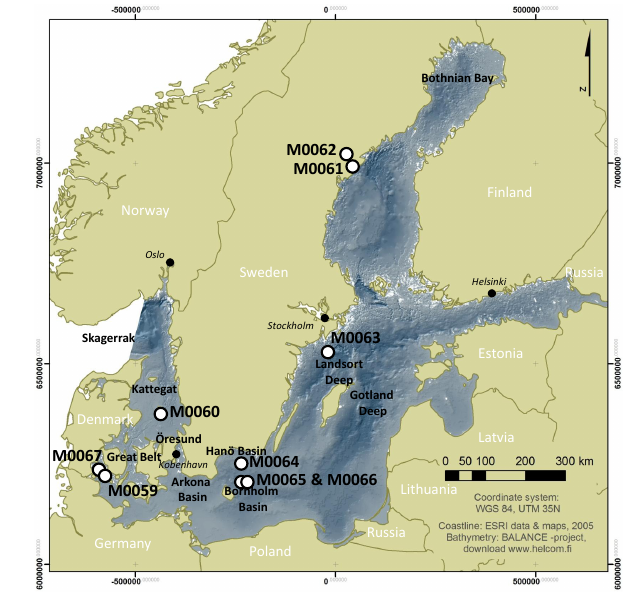
Figure 1. Bathymetric map of the Baltic Sea with the nine coring sites, M0059 to M0067. Source: IODP Leg 347 expedition Report.